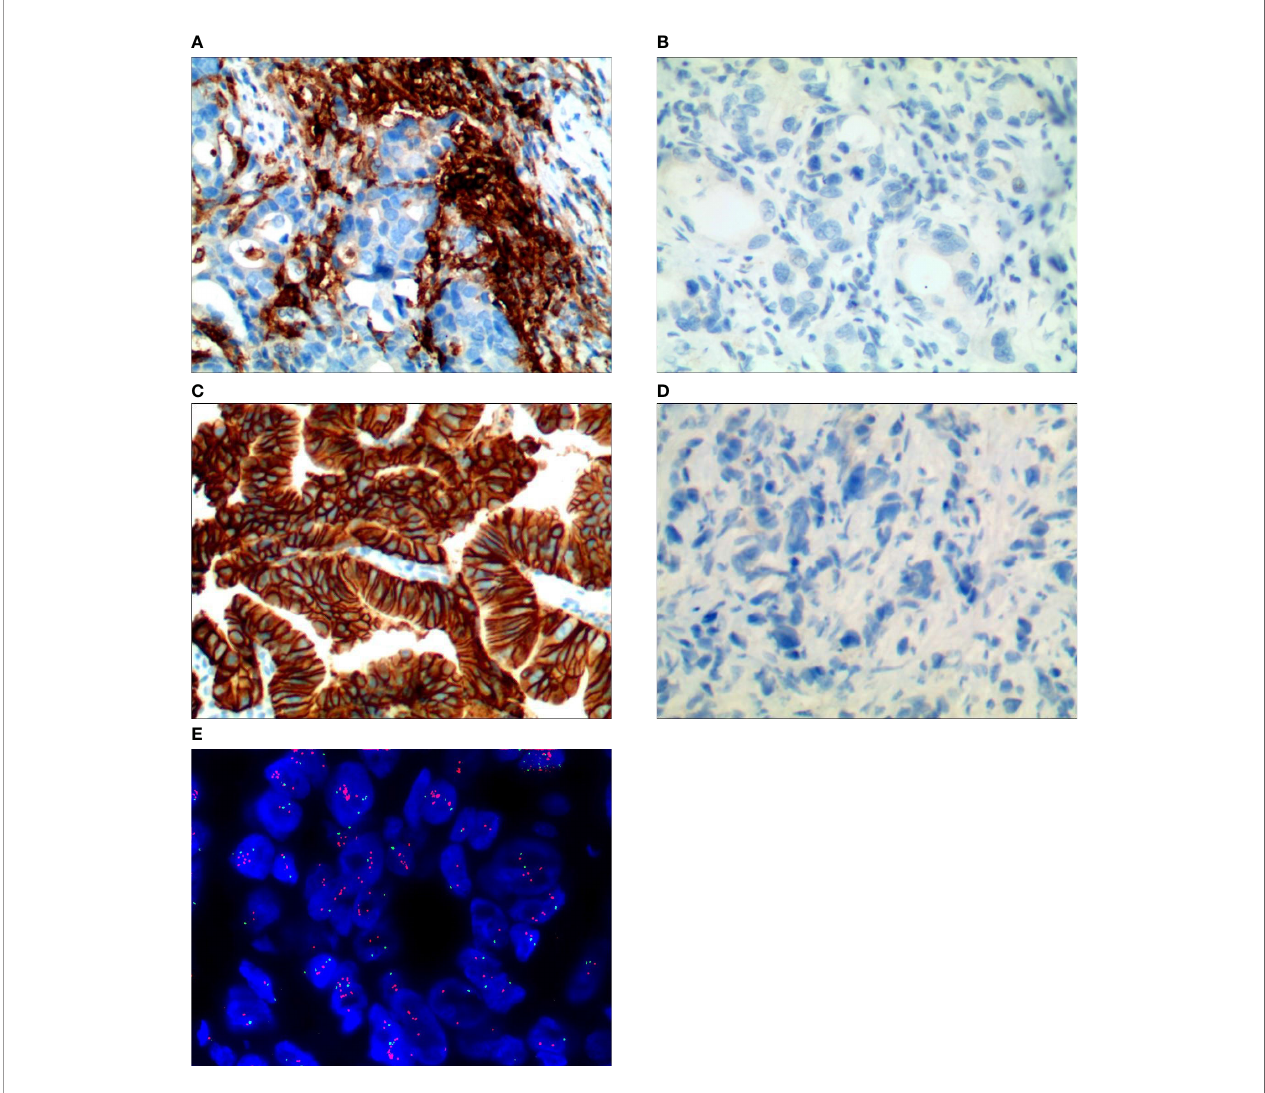
FIGURE 1 | Representative images of PD-L1 and HER-2 immunostaining/FISH results, (A) PD-L1 positive, (B) PD-L1 negative, (C) HER-2 positive by immunostaining, (D) HER-2 negative by immunostaining, (E) HER-2 positive by